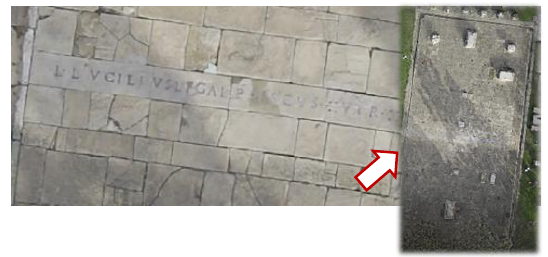
Figure 4. 1 cm resolution orthophoto of the bore area. On the right the detail of the engraving placed on the paved